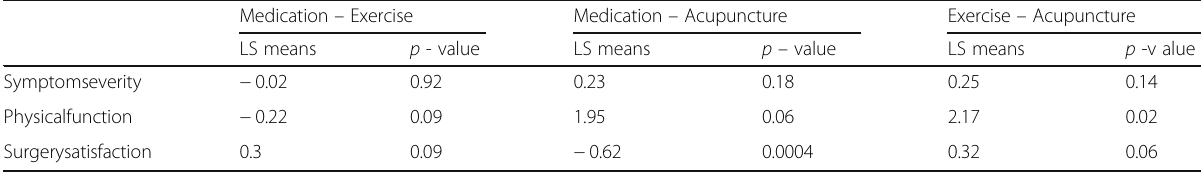
Table 3 Between-group differences in ZCQ least-square means adjusted for age, sex, BMI, and confounding factors Medication –